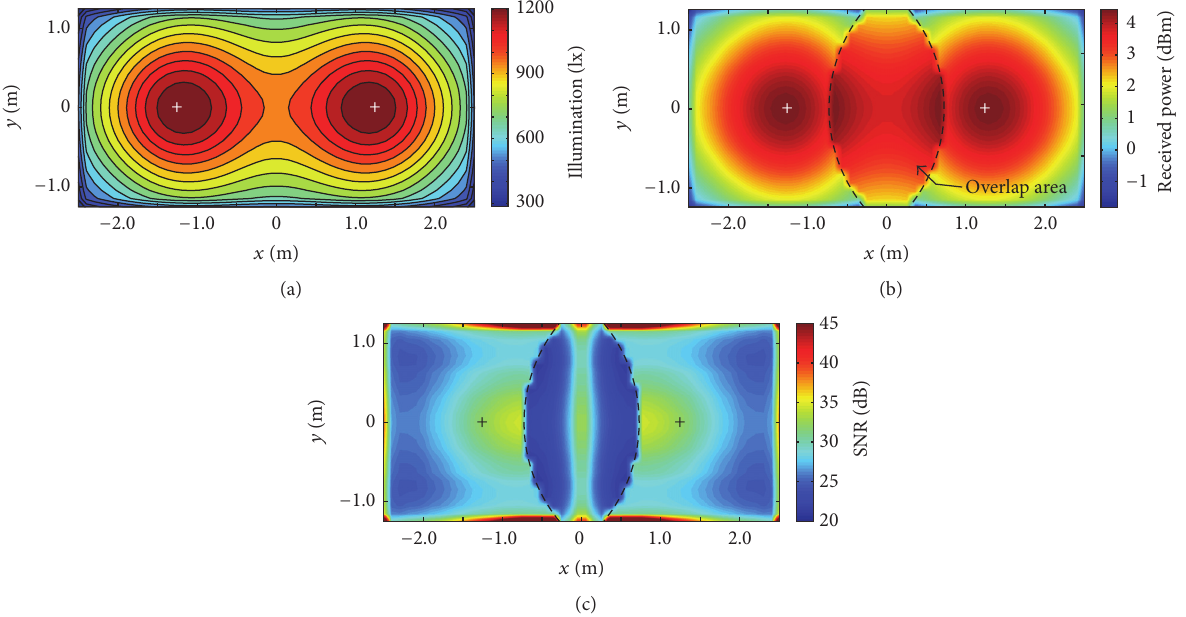
Figure 3: The profile of (a) illumination, (b) receiver power, and (c) SNR. The two LEDs are symmetrically arranged in a horizontal plane. LED1 and LED2 are at ( − 1.25, 0, 2.5) and (1.25, 0, 2.5). The receiver plane is at 𝑧 0 = 0.85